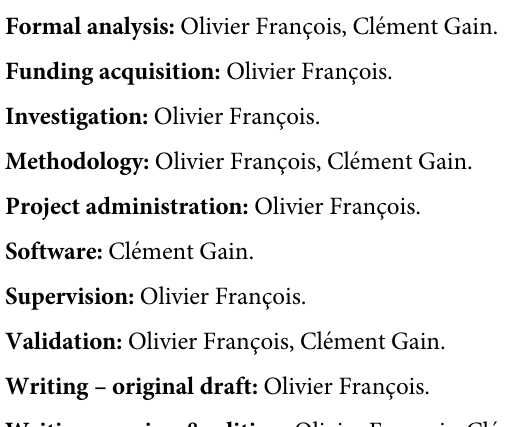
S9 Fig. Accuracy of approximation of F by PCA for K -population F -models. A-B ) Simu- ST lations with equal drift coefficients F = 0.1. The accuracy of the approximation of E ½ F � by k ST the sum of the K − 1 leading eigenvalues of the PCA is comparable to K / L (A) and the separa- tion of eigenvalues from the residual matrix is verified (B). C-D ) Simulations with unequal drift coefficients F = 0.2/ k . The accuracy of the approximation of E ½ F � diverged from K / L k ST when the separation of eigenvalues did not hold. In all simulations, ancestral frequencies were drawn from a beta distribution with shape parameters a = 1 and b = 4. Sub-population samples had size equal to n = 20, the total population size was n = 20 × K ), and the number of SNP loci k was L � 19850. S10 Fig. Estimates of ancestry coefficients for 241 Swedish accessions of A. thaliana . Ances- try coefficients obtained from the spatially explicit ancestry estimation program tess3r with K = 3 populations. The southern group exhibits substantial levels of mixed